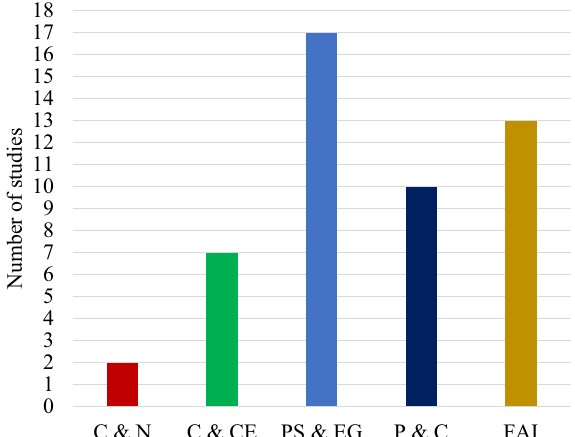
Figure 5. Number of studies related to applications of JSO.